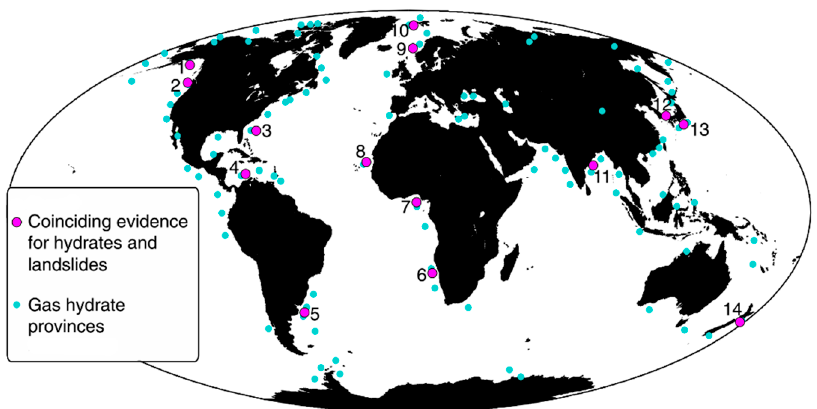
Figure 1. Global compilation of large submarine landslides in areas with gas hydrates [8].